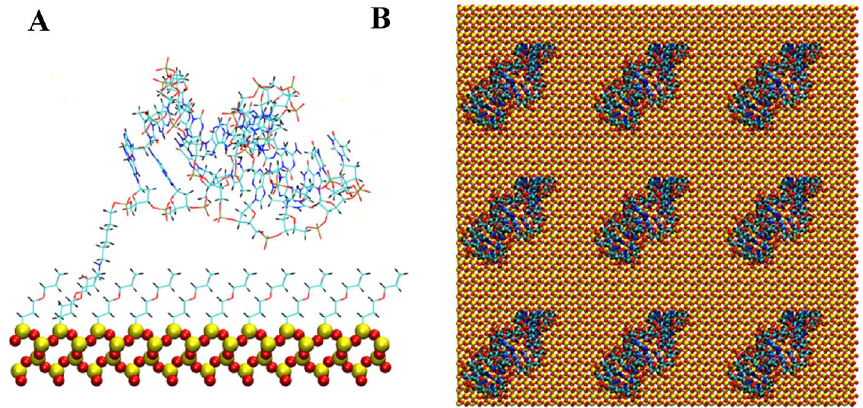
Figure 2. Anti MUC1 aptamer tethered to SiO 2 biosensor substrate in configuration 1 (5 ′ end attachment, parallel to surface, low density). (A) Side view of simulation cell (B) Top view with periodic display. Water and ion molecules are not displayed.